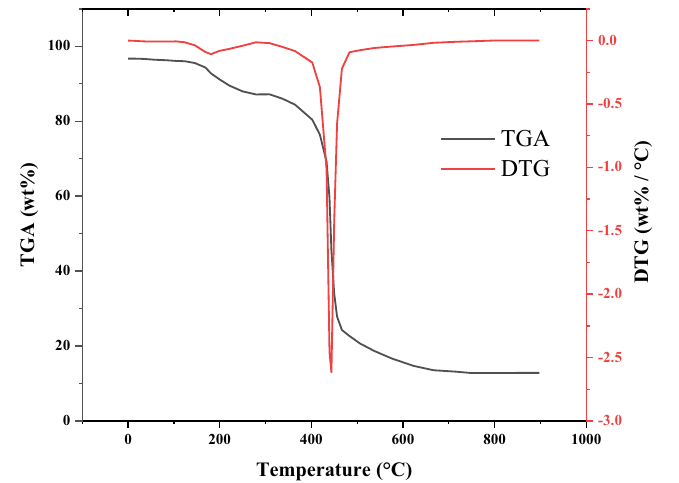
Figure 3. TGA and DTG curves for MSAC adsorbent.